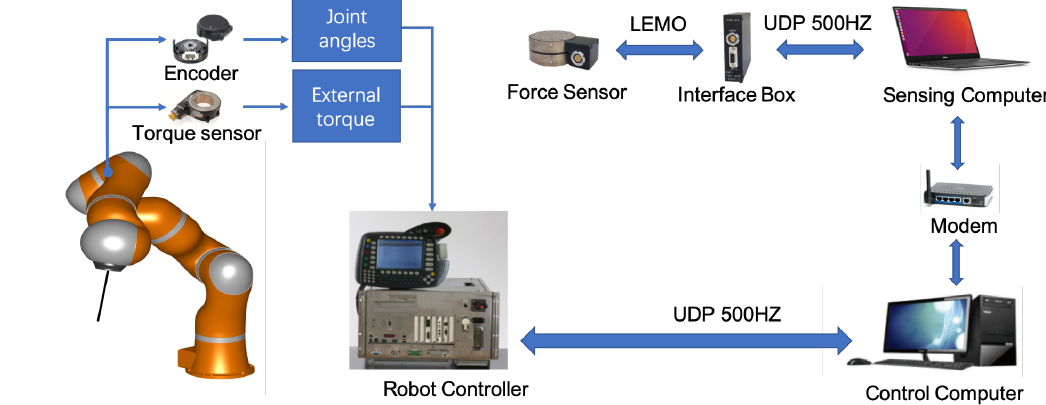
Figure 7. Overview of the developed robot control system. Multiple sensors including an encoder, a torque sensor and a force sensor, are adopted to collect the corresponding motion and force data.